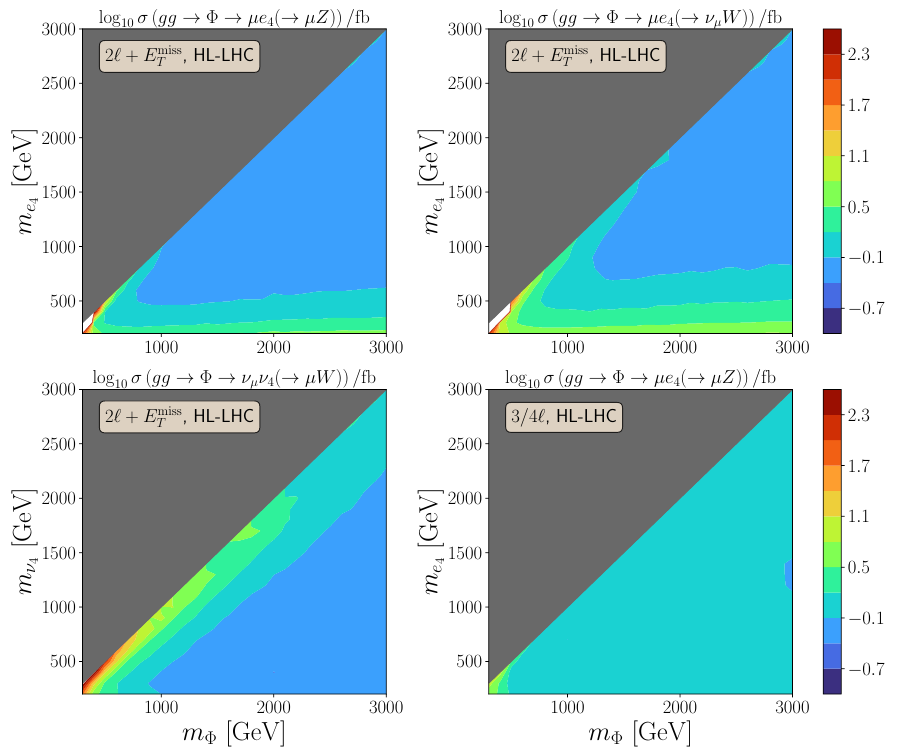
Figure 5 . Projected upper bounds on σ ( gg → Φ → ‘‘ 4 ( → ‘ 0 V )) at the HL-LHC. See the texts for the